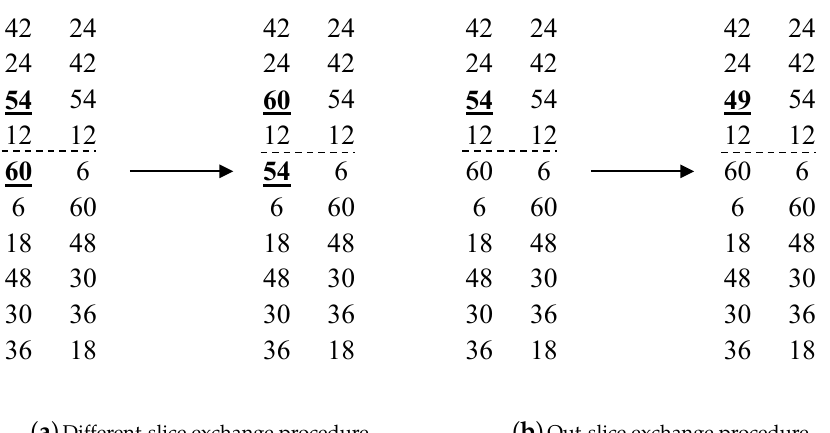
( a ) Different-slice exchange procedure ( b ) Out-slice exchange procedure Figure 2. ( a ) the different-slice procedure: exchange 54 in M ( 1 : 4,1 ) with 60 of τ ( b ) in M ( 5 : 10,1 ) ; ( b ) the out-slice procedure: replace 54 in M ( 1 : 4,1 ) with 49 of τ ( b ) in the out-slice